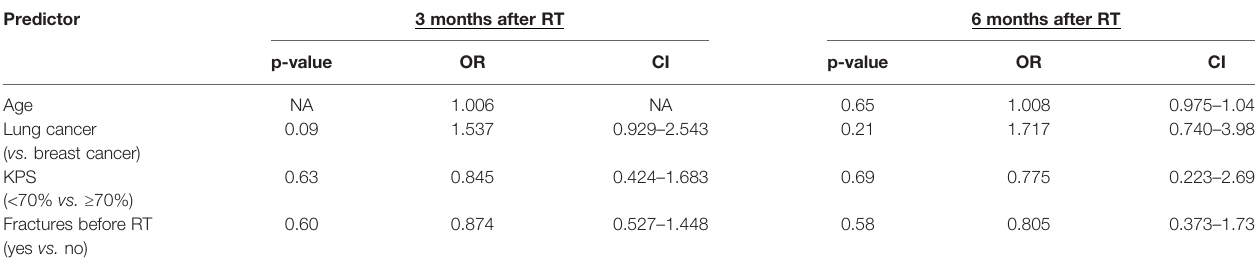
TABLE 3B | Univariate analysis of prognostic factors related to stabilization of initially unstable SBM according to Taneichi score.